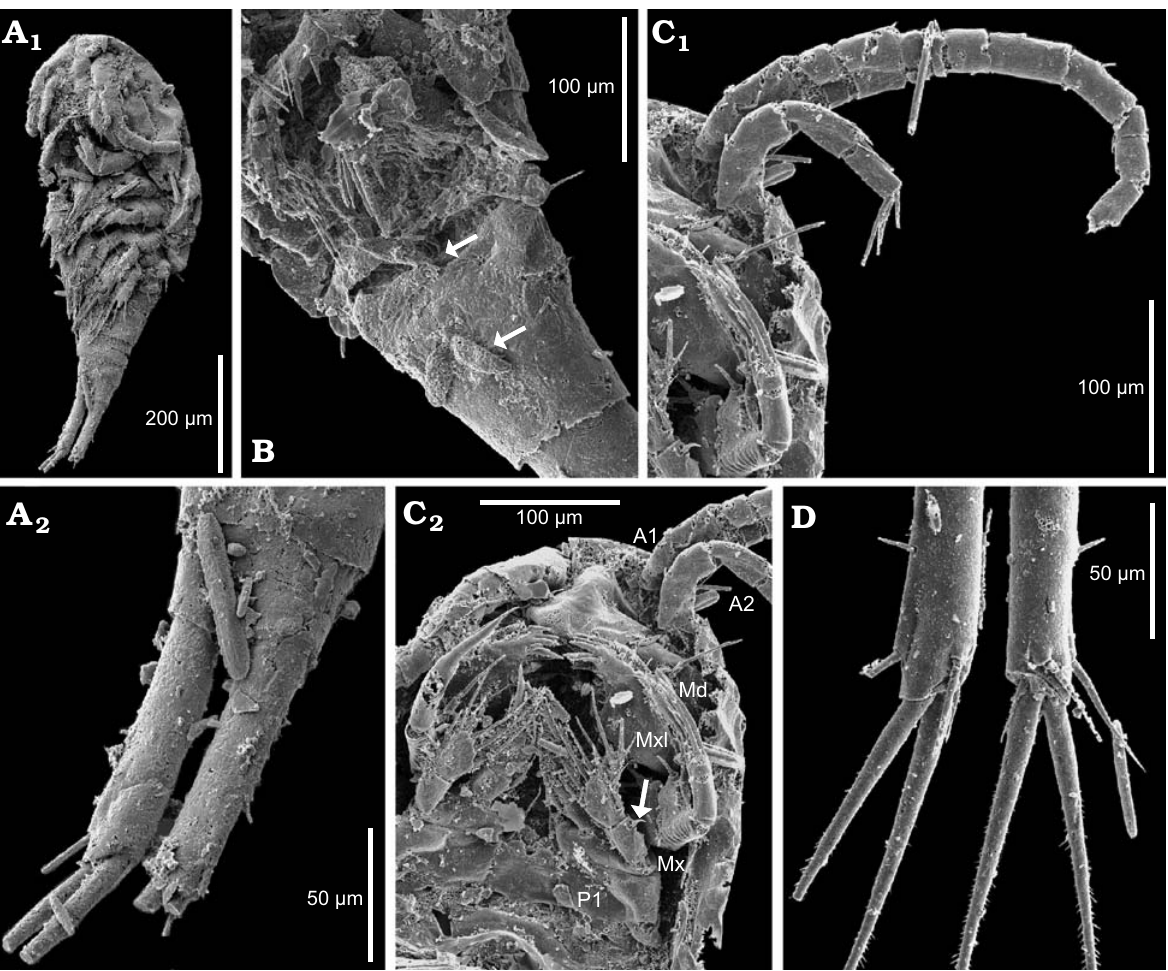
Fig. 2. Adult female of cyclopid copepod Apocyclops californicus sp. nov. from Mud Hills, Southern California; Burdigalian–Langhian, Miocene. A . UMNH IP 4824 holotype, habitus (A 1 ) and anal somite and caudal rami (A 2 ) in ventral view. B . UMNH IP 4833, pediger 5 and genital double-somite with two pairs of spermatophores (arrowed) in ventral view. C . OUMNH NT.233, 11-segmented antennule and antenna with allobasis in ventral view (C 1 ), cephalothoracic appendages (arrow shows oblique spine on the first exopodal segment of leg 1) in ventral view (C 2 ). D . UMNH IP 4852, caudal setae with setules on setae IV and V in dorsal view. A1, antennule; A2, antenna; Md, mandible; Mxl, maxillule; Mx,: maxilla; P1, leg